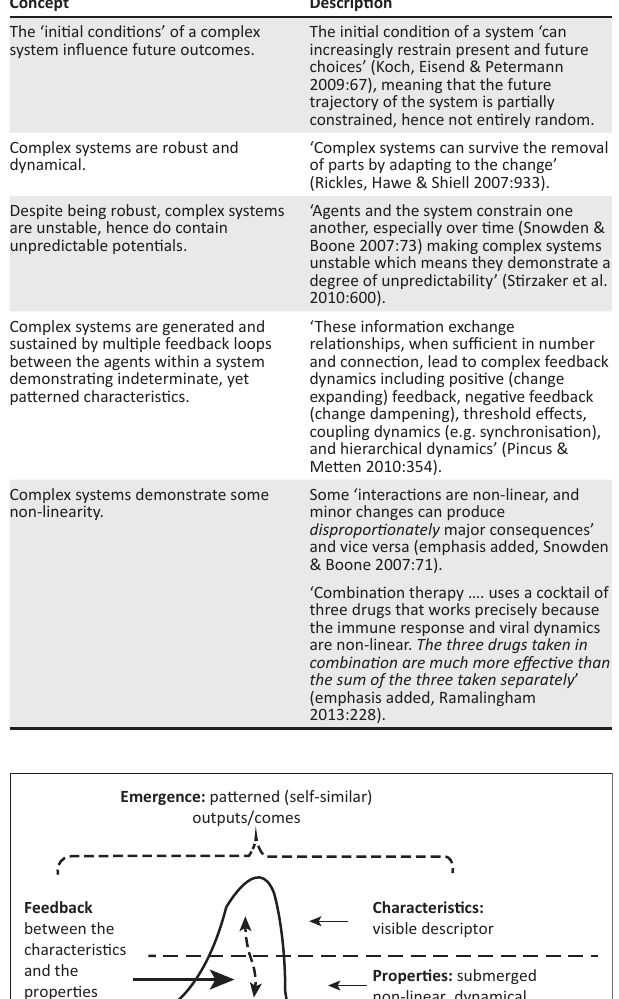
TABLE 2: Aspects relating to complexity that have influenced the development of the Framework.